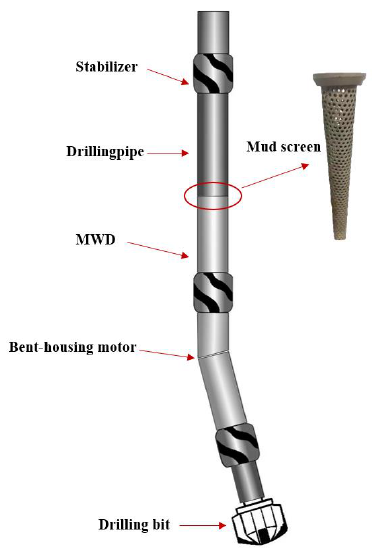
Figure 1. The mud screen placed in the MWD tool.